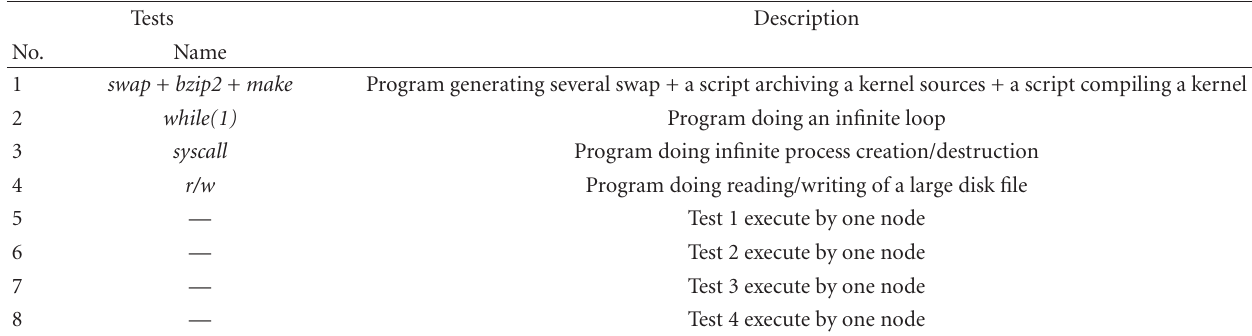
Table 5: Description of tests used in order to vary the system load.